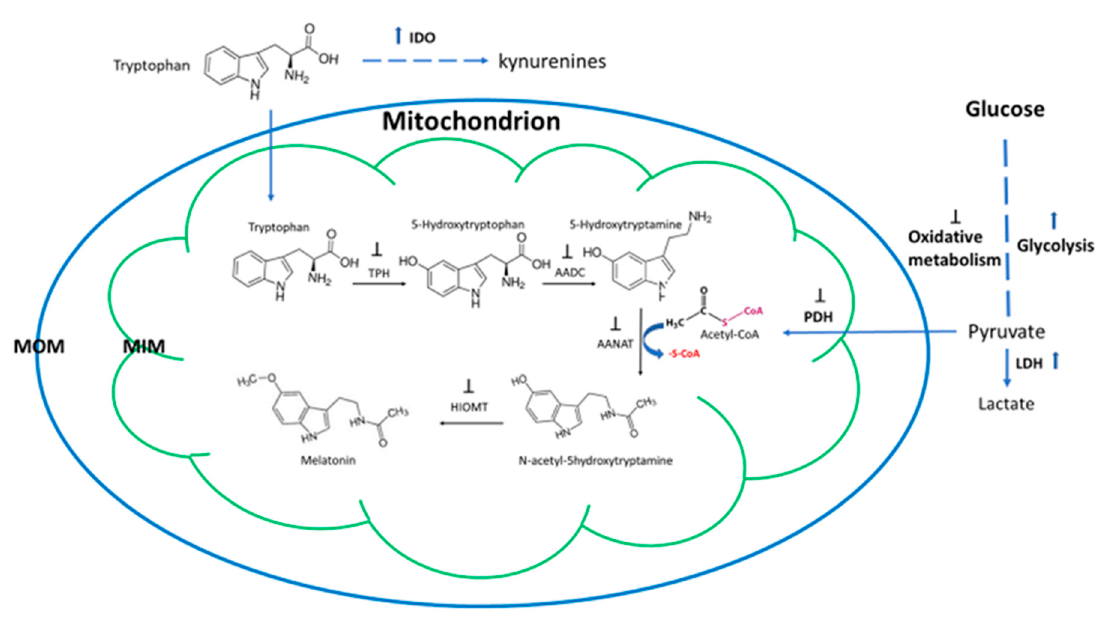
Figure 3. The potential mechanisms of virus to attack mitochondrial melatonin synthetic pathway.